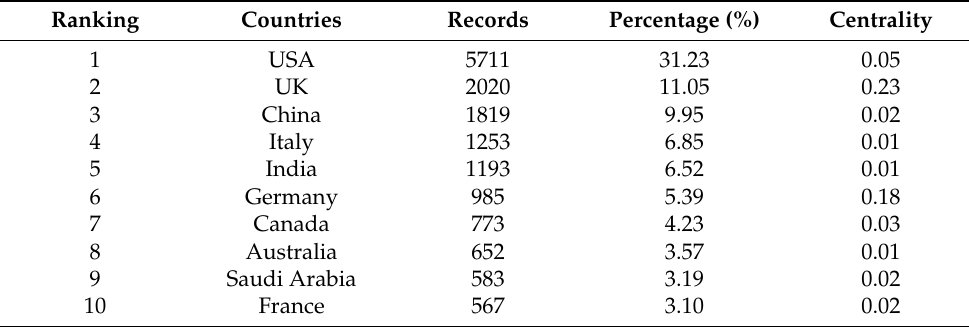
Table 1. Top 10 most productive countries in COVID-19 vaccine